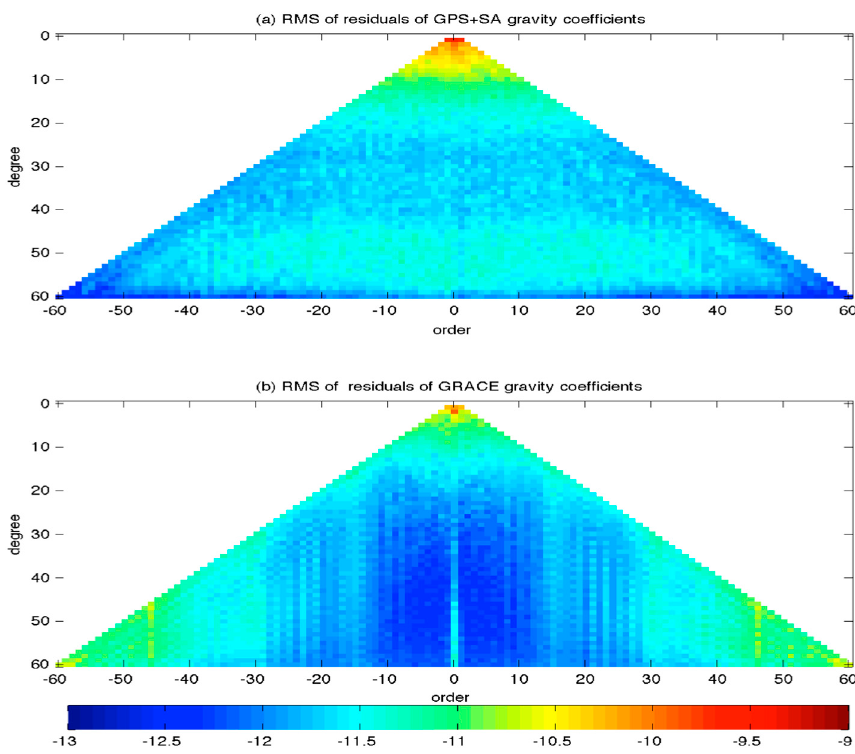
Figure 13. Logarithm of RMSs of the spherical harmonic coefficients after removing the linear trend, annual and semi-annual cycles from monthly values of each Stoke’s coefficient for GPS+SA and GRACE. Vertical axis is degree n . Horizontal axis represents order m ( m < 0 for SINE coefficients, m > 0 for COSINE coefficients). Degree-1 Stoke’s coefficients of GRACE come from [38]. ( a ) A logarithm of RMSs of GPS+SA Stoke’s coefficients, ( b ) a logarithm of RMSs of GRACE Stoke’s coefficients.